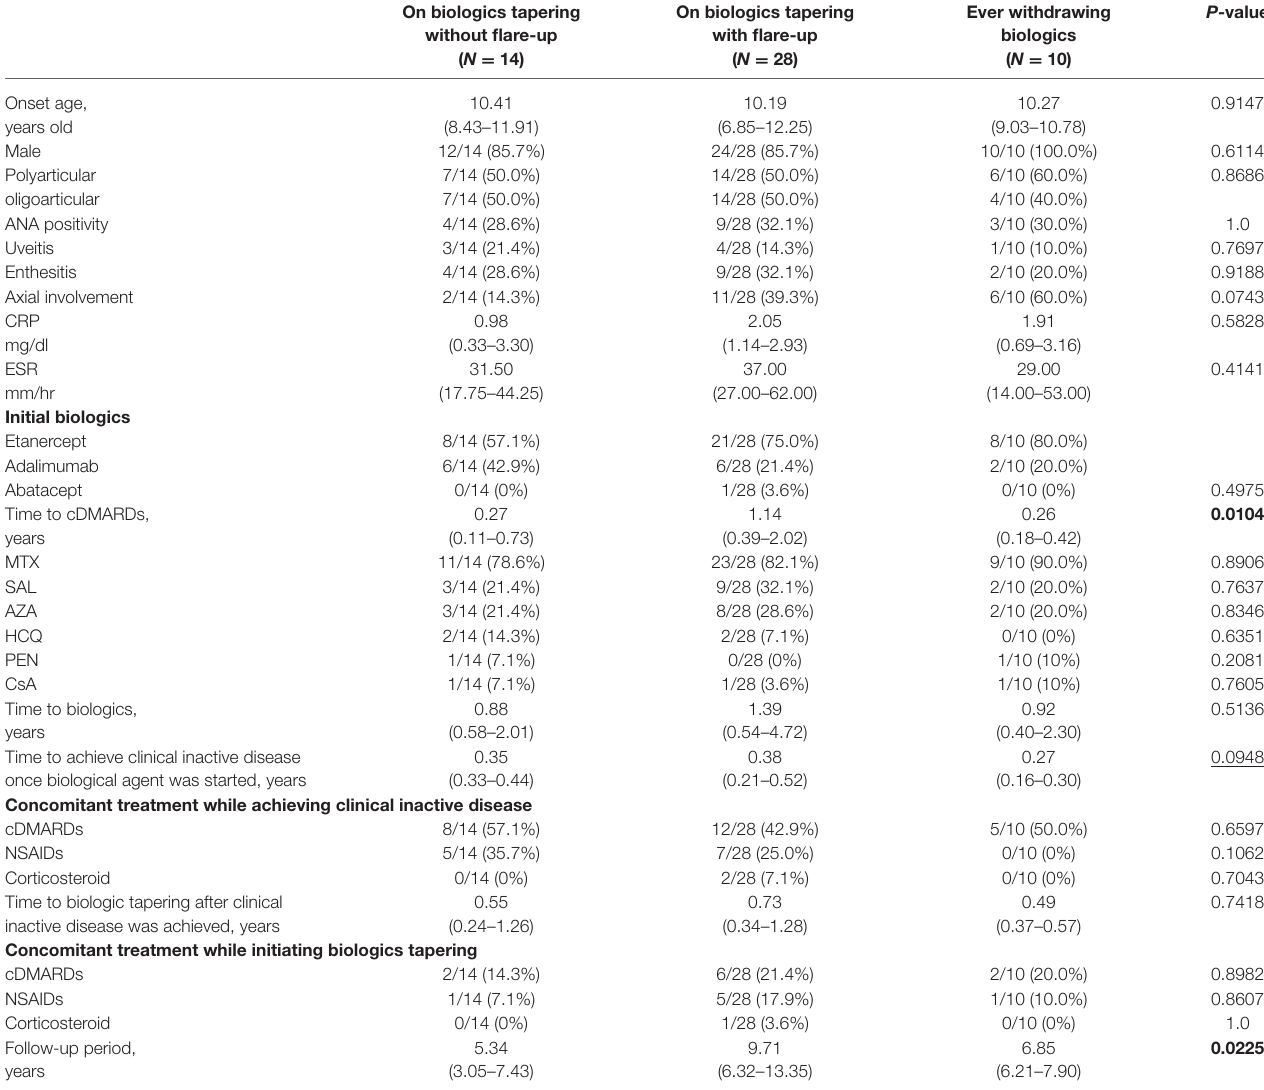
TABLE 3 | Demographics and clinical manifestations in ERA patients stratified by biologics tapering.